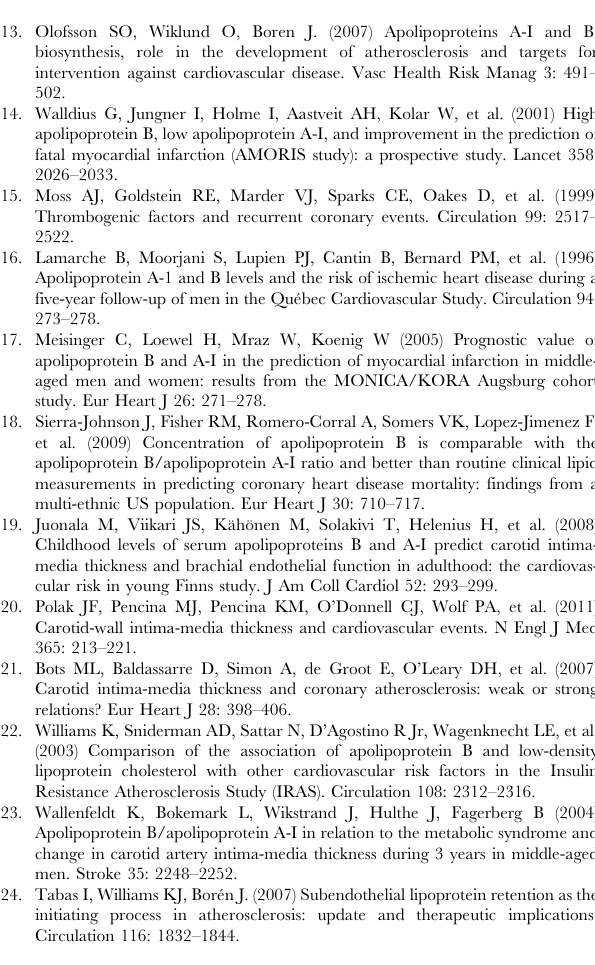
Table S1 Odds ratios per standard deviation increment of different lipids or lipid ratio with a 95% confidence interval for elevated CIMT in metabolic syndrome population. Data are odds ratios (ORs, 95%